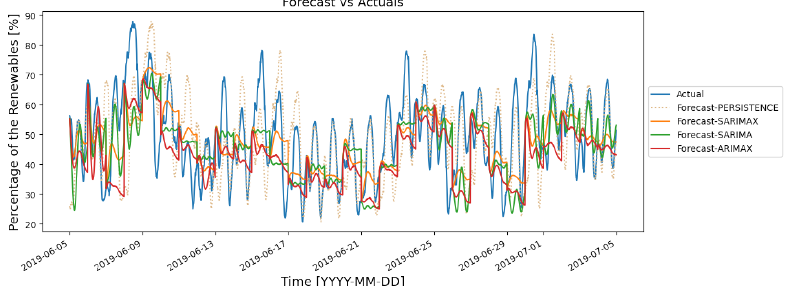
Figure 5. Forecasts for a one month period in autumn 2019.